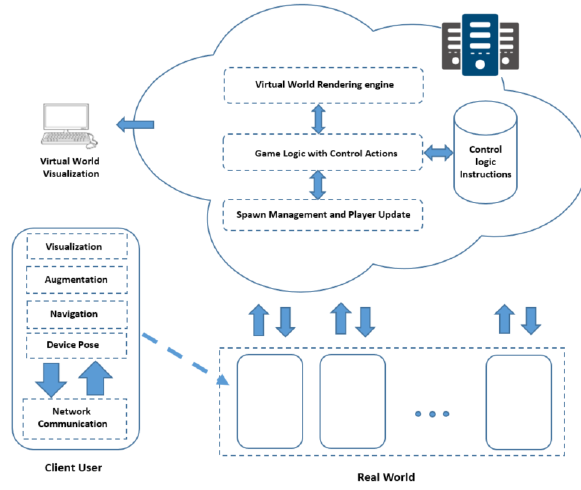
Figure 2: System Overview of BCAR